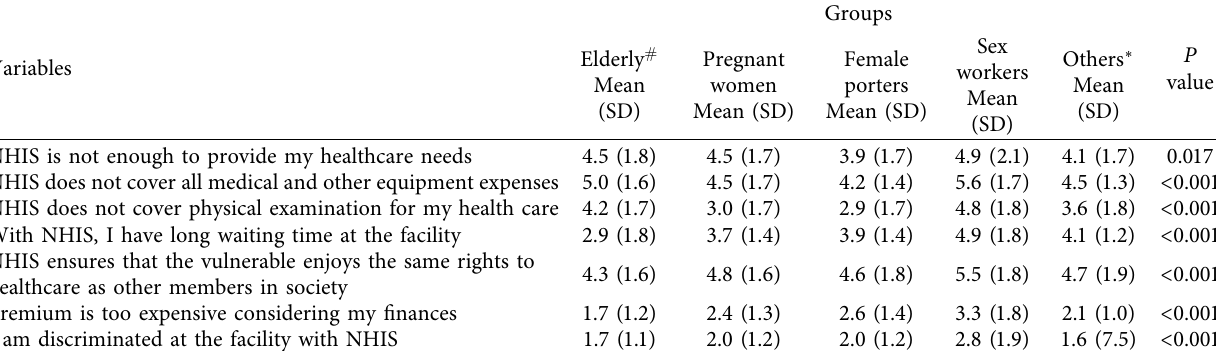
Figure 1: Reasons for the inability to access care. Table 3: Perception of the NHIS by vulnerable